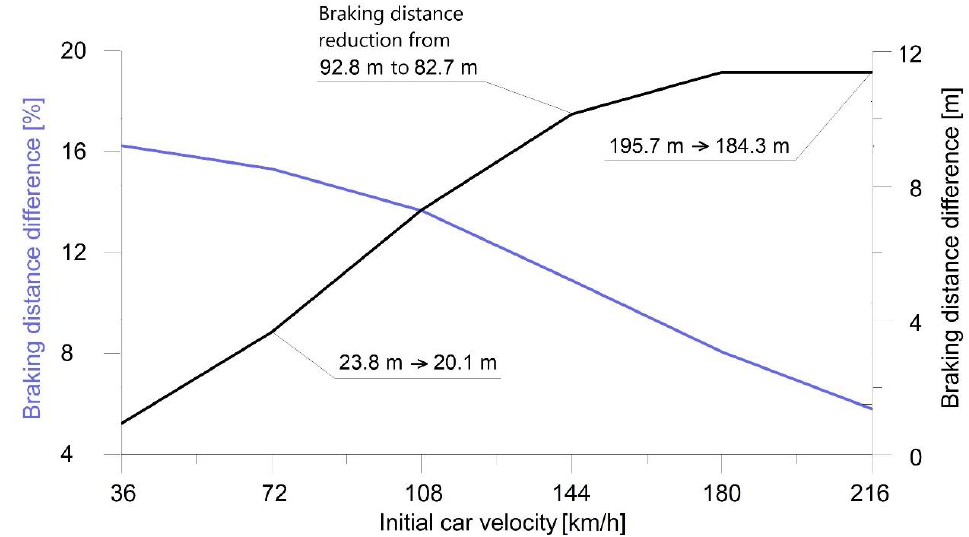
Figure 37. Differences of braking distance in function of speed of braking commencement, with and without FDDG.